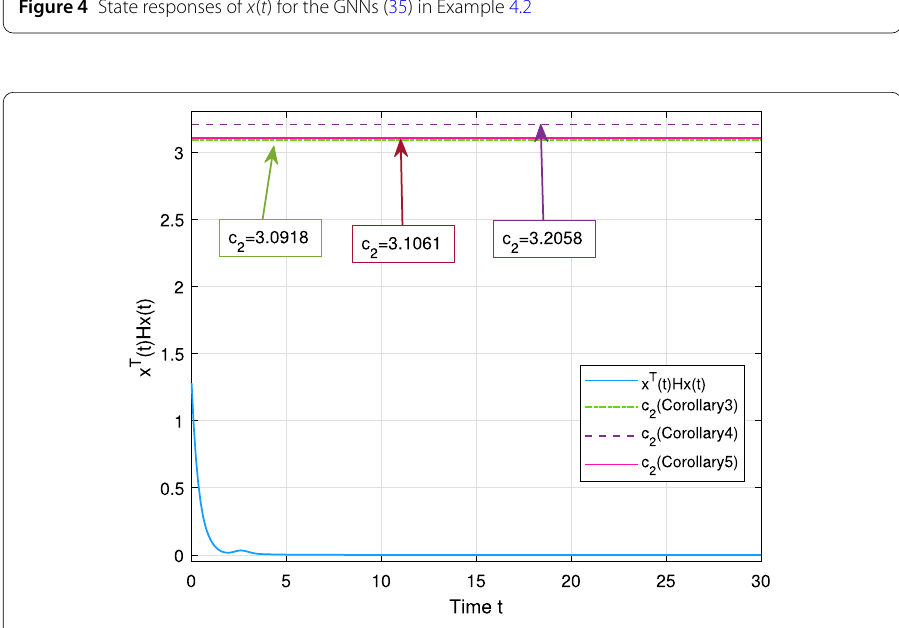
Figure 5 Time history of x T ( t ) Hx ( t ) for the GNNs (35) in Case I Example 4.2, T = 30